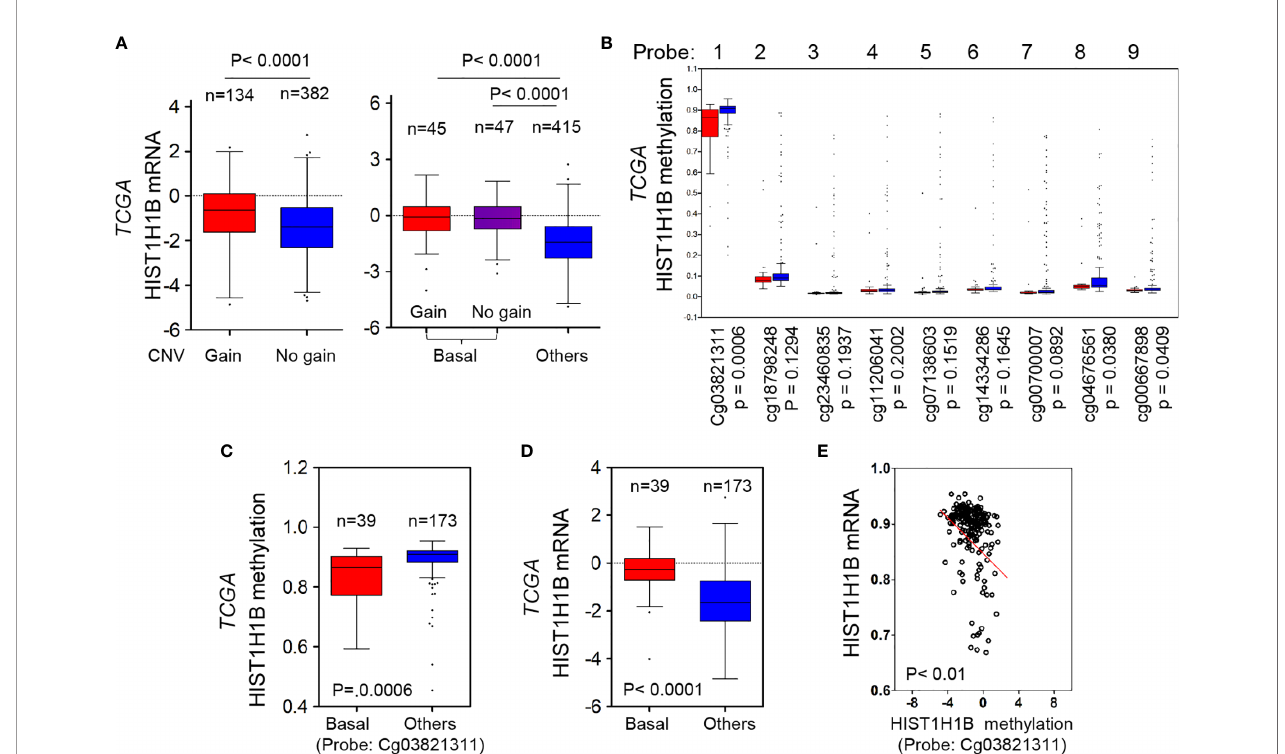
FIGURE 2 | HIST1H1B overexpression associates with HIST1H1B's copy number ampli fi cation and promoter hypomethylation. (A) Box-plots indicated the association of HIST1H1B expression with its copy number status (gain or no gain) in breast cancer from the TCGA dataset. (B) Analysis of HIST1H1B methylation using multiple 450 K probes in different subtypes of breast cancer from the TCGA dataset. (C) Box-plots indicated HIST1H1B methylation in different subtypes of breast cancer from the TCGA dataset. (D) Box-plots indicated HIST1H1B mRNA in different subtypes of breast cancer from the TCGA dataset. (E) Analysis of the TCGA dataset